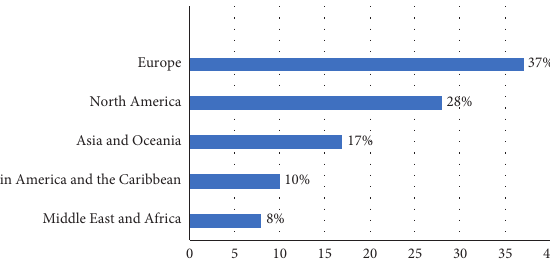
Figure 2: Industry 4.0 initiatives launched worldwide by region.